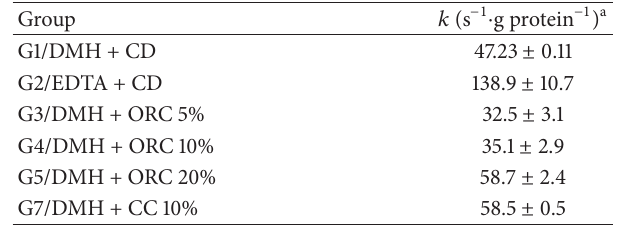
Table 2: Catalase activity in the liver tissues ( 𝑛 = 3 ), with standard deviations. The rate constant of first-order reaction ( 𝑘 ) was adopted (s −1 ⋅ g protein −1 ), as a measurement of enzyme activity. Results are shown for liver samples from G1/DMH + CD, G2/EDTA +